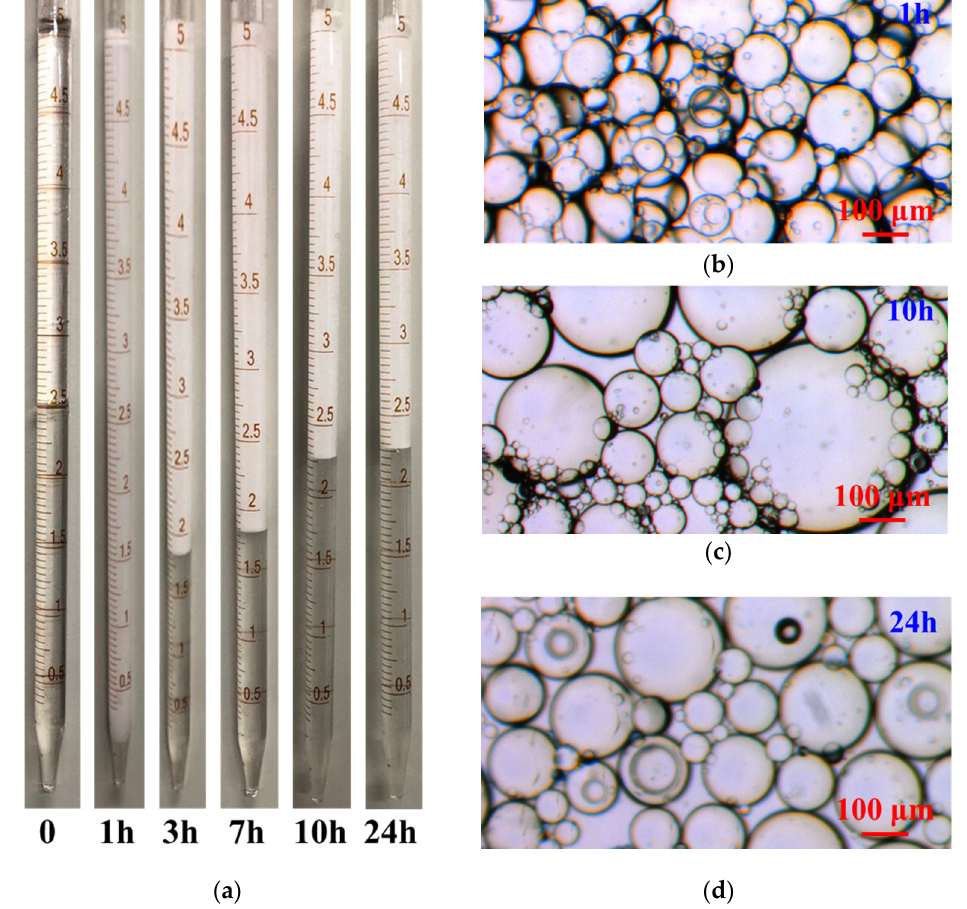
Figure 2. Emulsion phase behavior as a function of time at reservoir temperature. ( a ) Emulsion phase behavior as a function of time at reservoir temperature; ( b ) the microscopic images of the emulsion at 1 h; ( c ) the microscopic images of the emulsion at 10 h; ( d ) the microscopic images of the emulsion at 24 h.